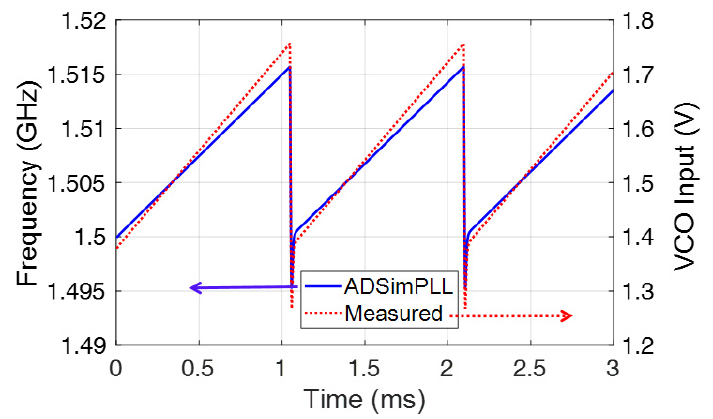
Figure 9. Measured ramp signal driving the VCO; and VCO output frequency as a function of time.